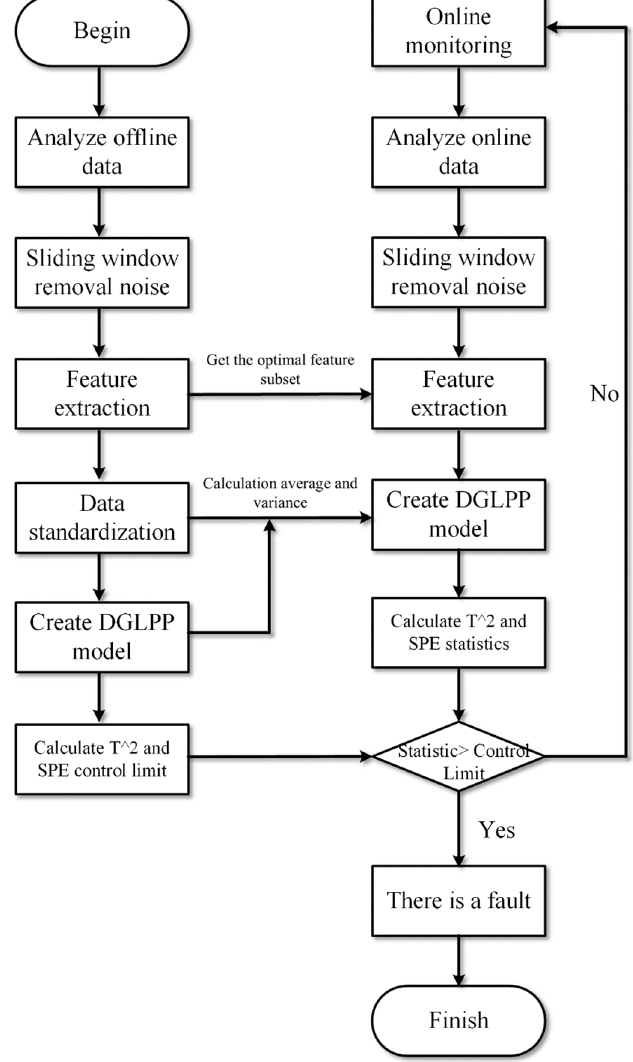
Figure 1. Framework diagram of the whole control system.